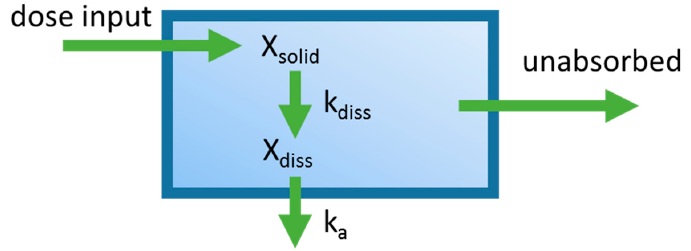
Figure 2. Diagram of the mixing tank model which represents the gastrointestinal (GI) tract as a single well-stirred compartment. k a is the absorption rate constant, X diss is the amount of drug dissolved in the GI tract. k diss is the dissolution rate constant, and X solid is the dose that has been placed into the GI tract. The oral absorption rate is governed by k a and X diss . The dissolution rate is governed by X solid and k diss .